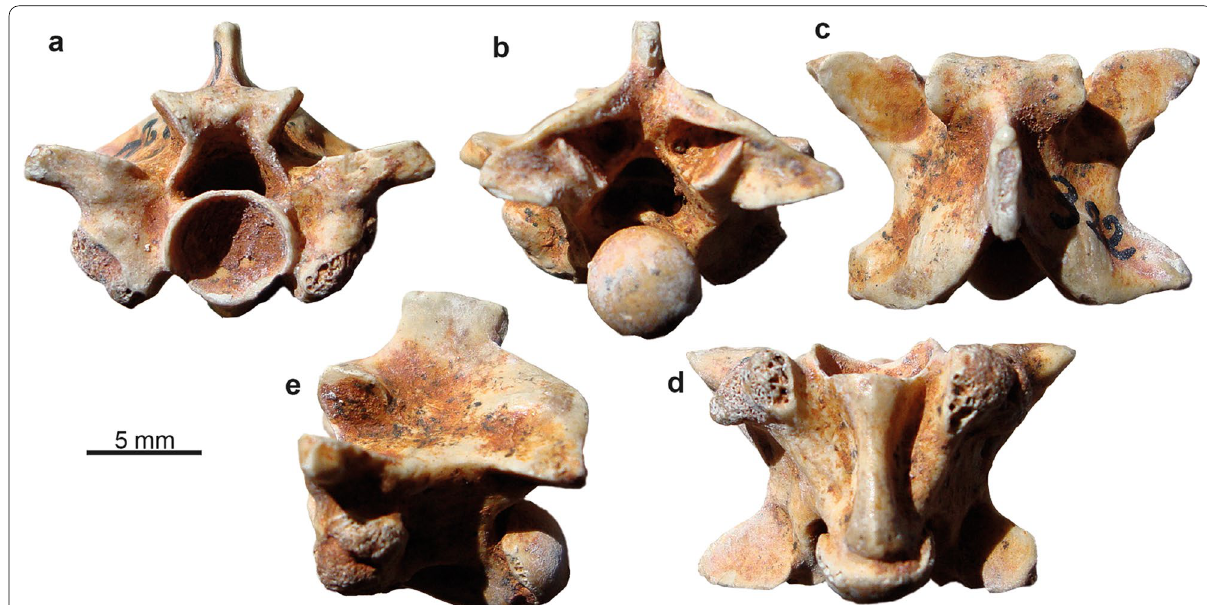
Fig. 75 Phosphoroboa filholii comb. nov. from an imprecisely known locality in the Phosphorites du Quercy: holotype posterior trunk vertebra (MNHN.F QU16322) in anterior ( a ), posterior ( b ), dorsal ( c ), ventral ( d ), and left lateral ( e )